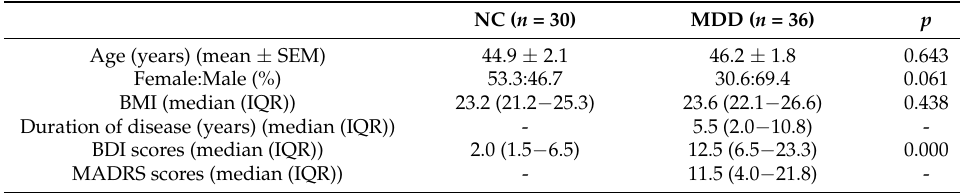
Table 1. Characteristics of participants.